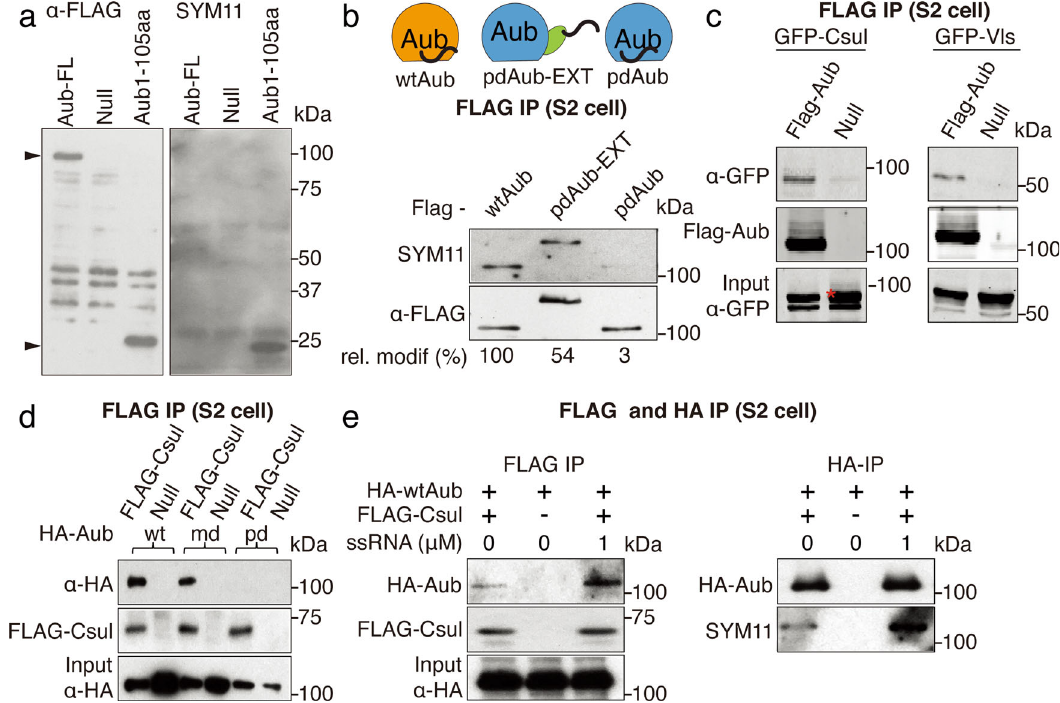
Fig. 6 RNA binding triggers a conformational change in Aub, exposing its N terminus to the methyltransferase Csul/Vls complex. a N-terminal region within Aub protein is not easily accessible to methylation. FLAG-tagged full length and N-terminal truncated (1-105aa) Aub were expressed in S2 cells and immunoprecipitated. Total protein and methylation level were assessed by Western blot. Arrowheads indicate correct size for full-length and N-terminal fragment, respectively. Experiment reproduced twice with similar results. b Top: scheme showing architectures of different Aub constructs expressed and IP-ed from S2 cells. EGFP inserted between the N-terminal and PAZ domain (pdAub-EXT) arti fi cially exposes N-terminus in absence of piRNA binding. Bottom: western blot analysis of methylation states. Relative methylation level as estimated by the ratio of SYM11/FLAG band intensities normalized to wildtype is listed. Experiment reproduced twice with similar results. c Aub interacts with Csul and Vls in S2 cells. Co-IP Western blot of tagged transgenes. Asterisk indicates band corresponding to GFP-Csul in the INPUT. d Aub binding to Csul depends on RNA binding but not on Arg methylation. FLAG-Csul and HA-Aub transgenes were expressed in S2 cells and coIP followed by Western detection. Experiment reproduced twice with similar results. e RNA loading of Aub leads to increased binding to Csul and increased methylation of Aub. FLAG-Csul and HA-Aub were expressed in S2 cells, lysates were incubated in the presence or absence of ssRNA oligo prior to coIP followed by Western detection. Experiment reproduced twice with similar